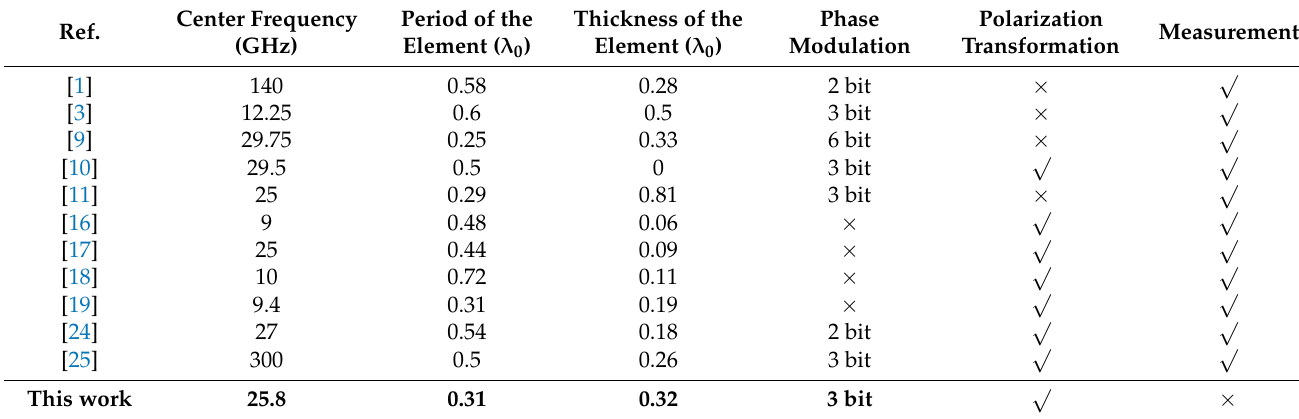
Table 2. Comparisons of the elements.